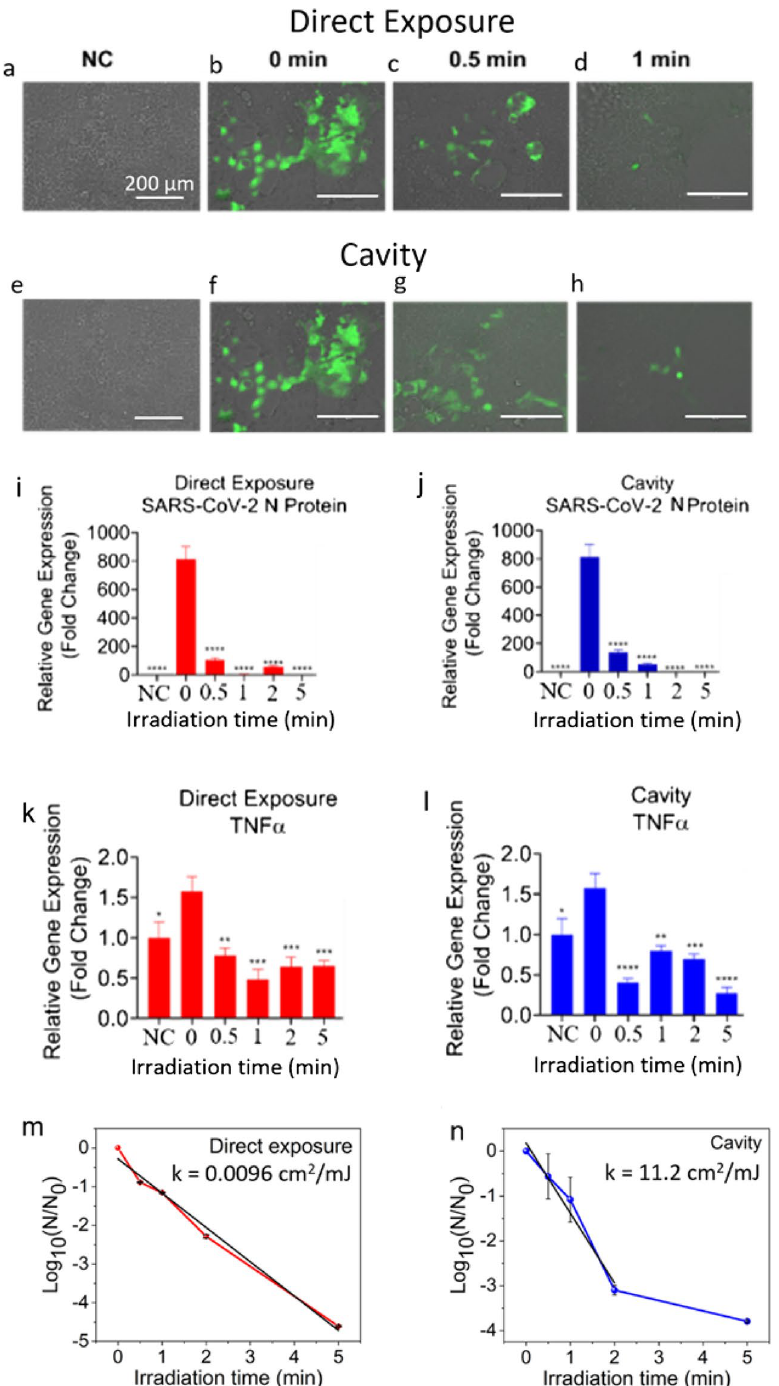
Figure 3. SARS-CoV-2 virus was exposed to indicated irradiation times of direct or cavity UVC laser light. Calu-3 cells were infected 24 h after seeding with the indicated groups of CoV-2 (0.1 MOI). ( a – h ) Images were taken 48 h post-infection using the EVOS microscope (Thermo Fisher). 200X. Scale bar = 200 µm. ( i – j ) SARS-CoV-2 N protein expression in Calu-3 cells. At 72 h post-infection RNA was extracted and qPCR performed. Average fold change ± SEM, compared to the negative control (NC), is shown (N = 3). A 1-Way ANOVA and Dunnett’s post hoc test was used to determine significance compared to 0 s. ( k – l ) Inflammatory marker expression in Calu-3 cells after SARS-CoV-2 infection. For the negative control, CoV-2 was exposed to UVC light under a handheld wand for 2 min. At 48 h post-infection RNA was extracted and qPCR performed. Average fold change ± SEM, compared to the negative control (NC), is shown (N = 3). A 1-Way ANOVA and Dunnett’s post hoc test was used to determine significance compared to 0 s. SARS-CoV-2 survival as a function of irradiation time via direct exposure ( m ) and cavity ( n ). * p < 0.05, ** p < 0.01, *** P < 0.001, **** P <